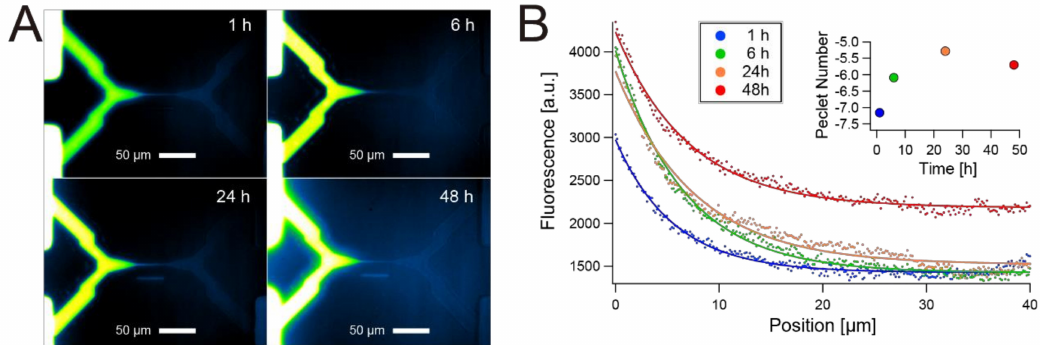
Figure 4. Concentration gradients generated on the H-shaped microfluidic configuration with the thin channel at the center. ( A ) Microscope image of fluorescence from Alexa Fluor 488 initially introduced to the bottom left end of the thin channel. Top right and bottom right ends of the thin channel were Laplace pressurized at the inlets/outlets after introducing the fluorophore. ( B ) Time evolution of fluorescence intensity profile along the thin channel region obtained from ( A ). Solid line curves represent fitting of intensity data points to Equation (2). Peclet numbers obtained from the fitting were also